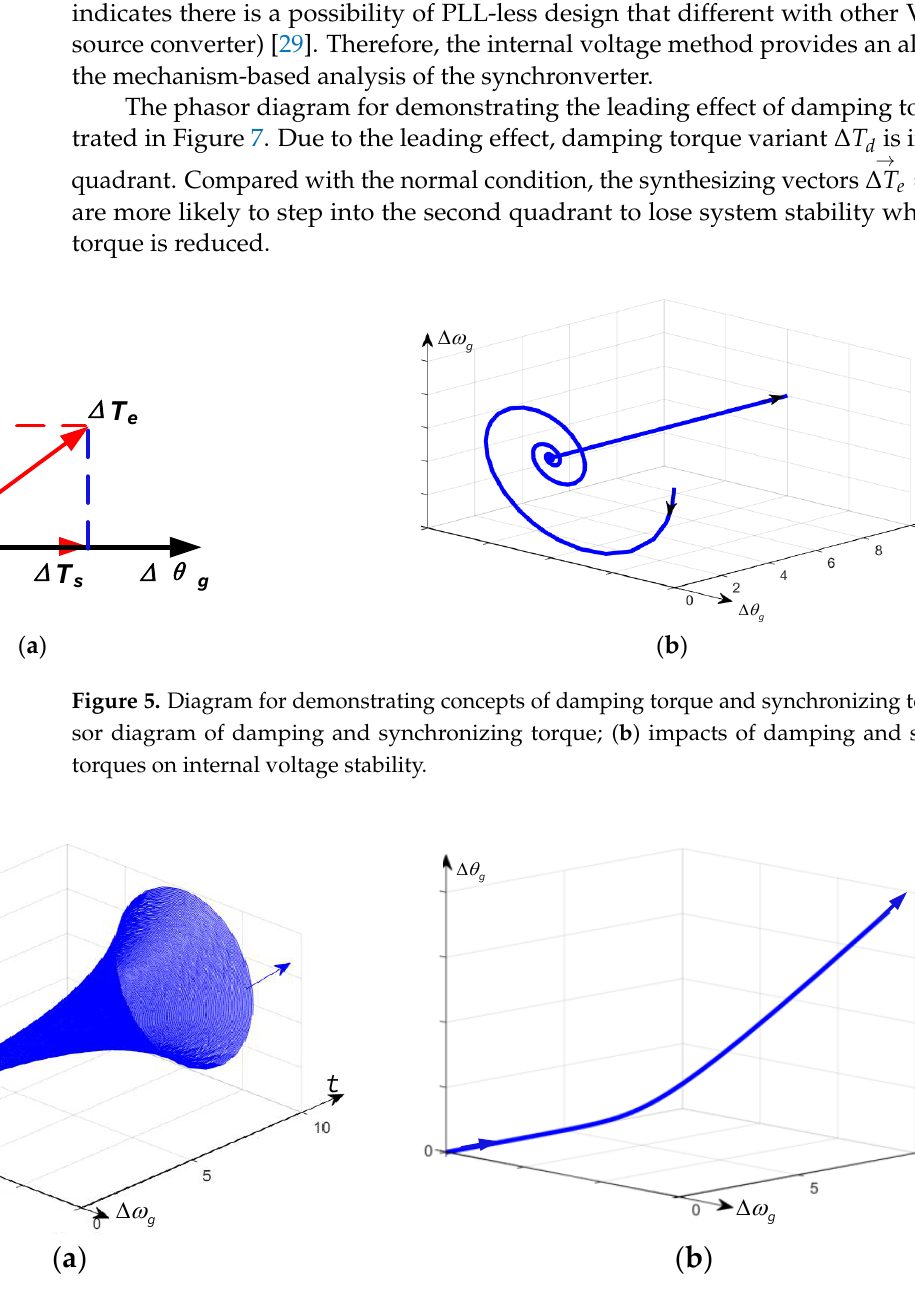
Figure 6. The dynamics of synchronverter internal voltage under two special circumstances: ( a ) negative damping torque; ( b ) negative synchronizing torque.